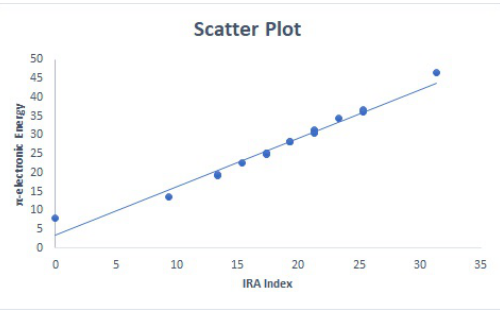
Figure 4. Scatter plot between the IRA index and the π -electronic